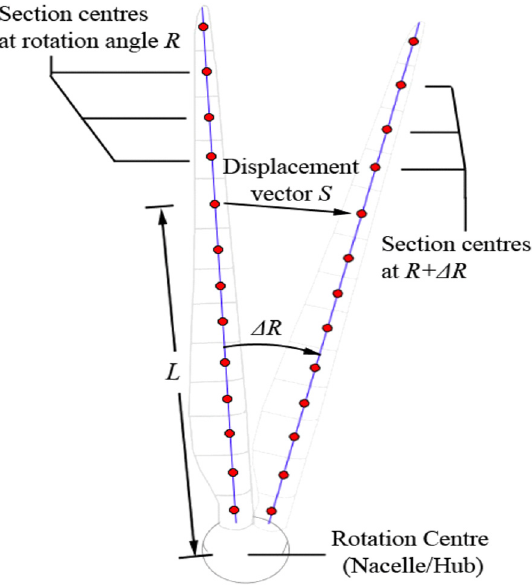
Figure 4. Blade portion centers for Doppler modelling of the transposition vectors [34].